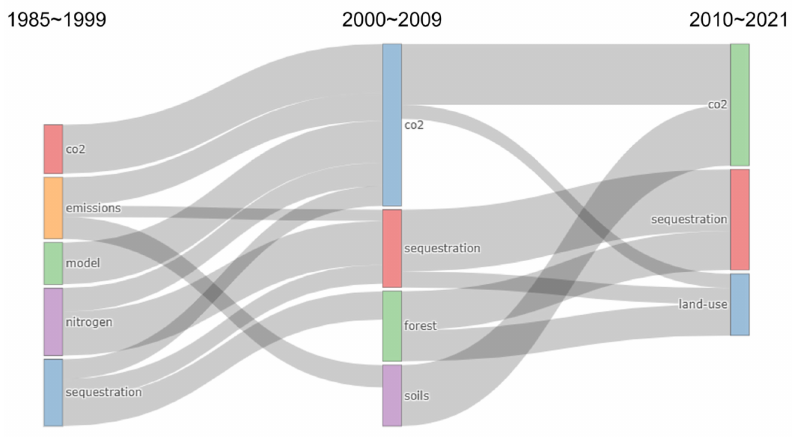
Figure 8. Evolution of Research Themes on the Effects of Land Use Change on Soil Carbon Sequestra- tion from 1985 to